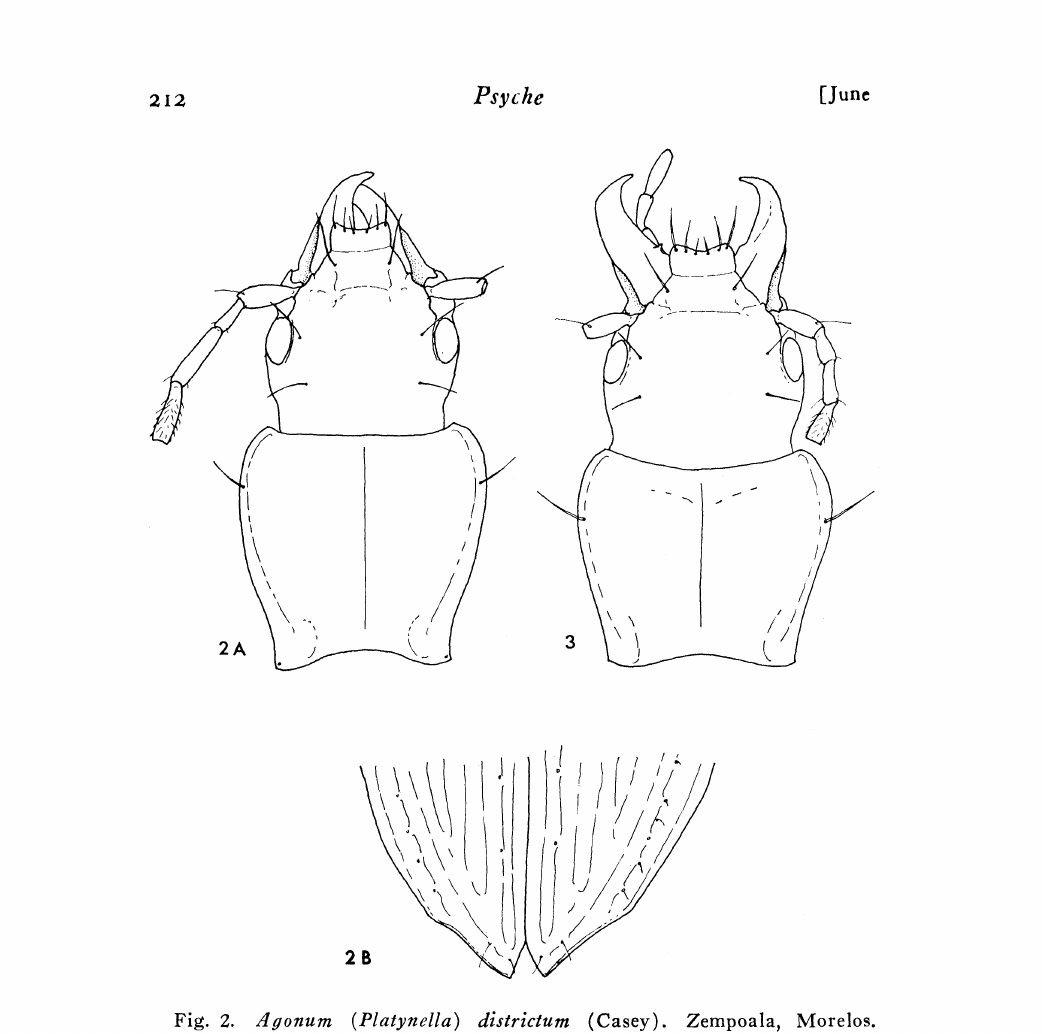
Fig. 2. /lgonum (Platynella) districtum (Casey). Zempoala, Morelos. A. Head and pronotum. B. Apices of elytra. Fig. 3. Agonum (Platynella) tolucense (Straneo), head and pronotum. Nevado de Toluea, Mexico. conspicuous sclerites; parameres conchoid, the right smaller. Type species of subgenus: A nchomenus (Platynella) districtus Casey (I920, p. 24), here